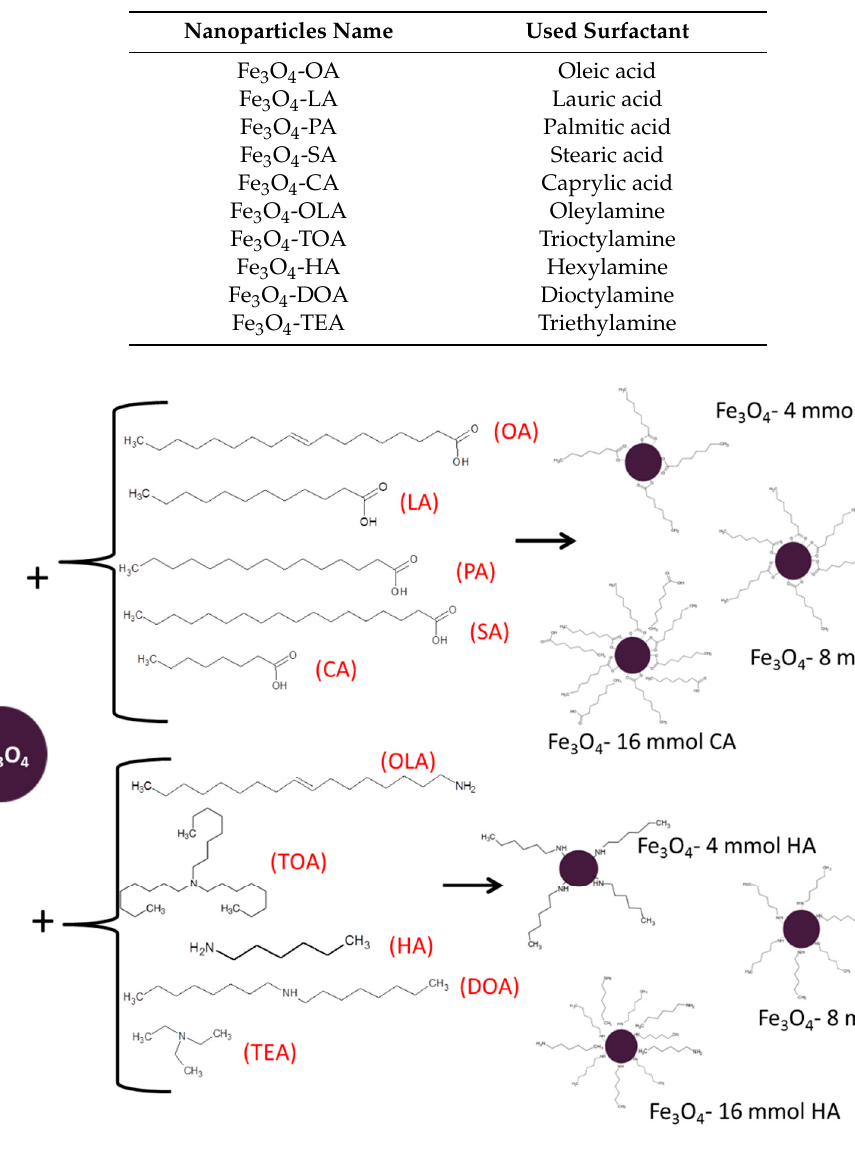
Table 1. Summary of types of used surfactants together with their abbreviated names.